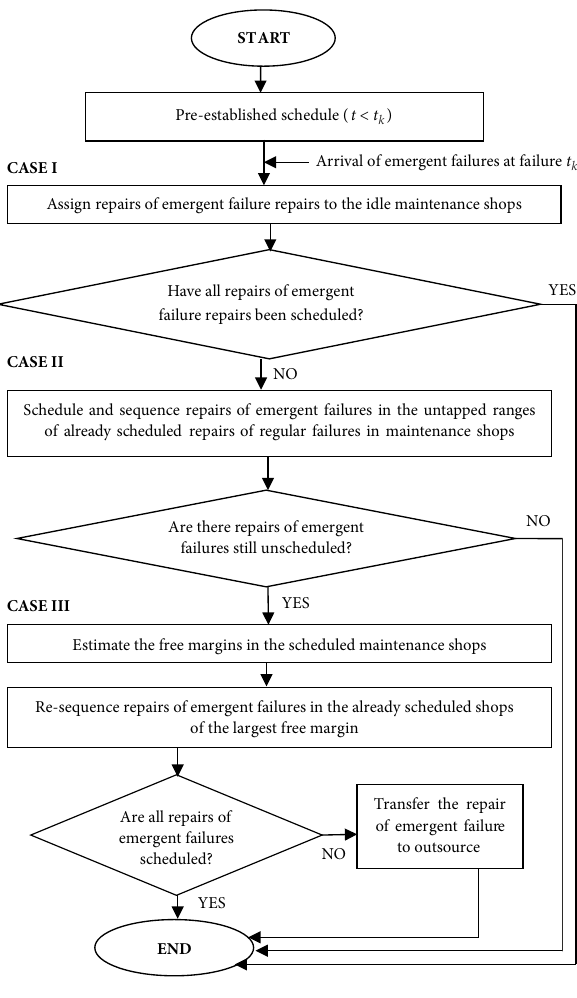
Figure 1. Proposed procedure for scheduling repairs of emergent